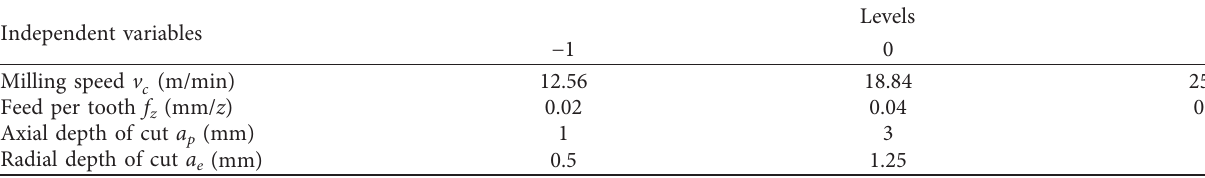
Table 3: Independent variables and the